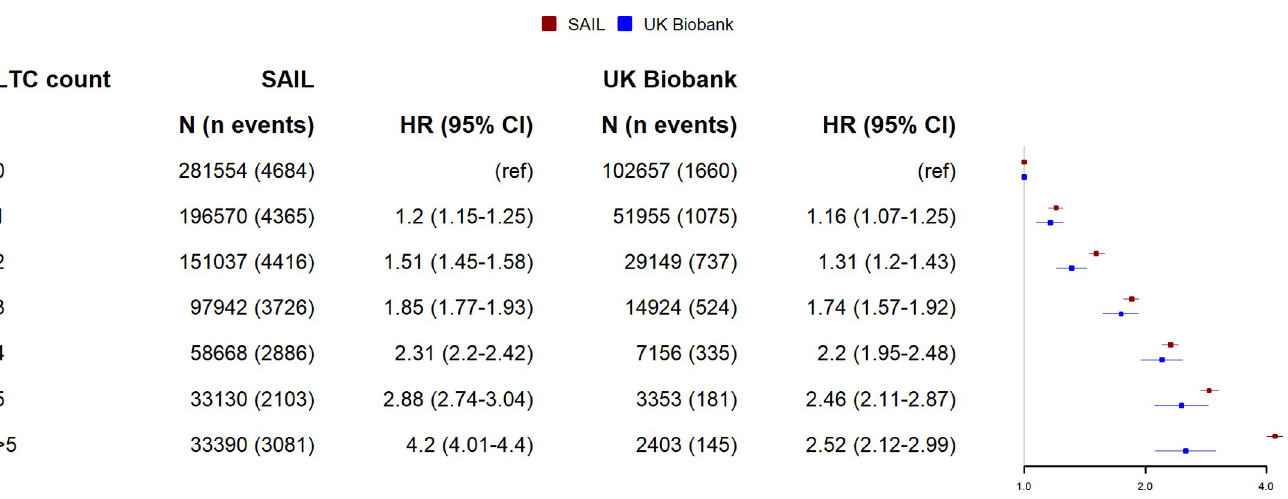
PLOS Medicine| https://doi.org/10.1371/journal.pmed.1003931 March 7, 2022 14 /